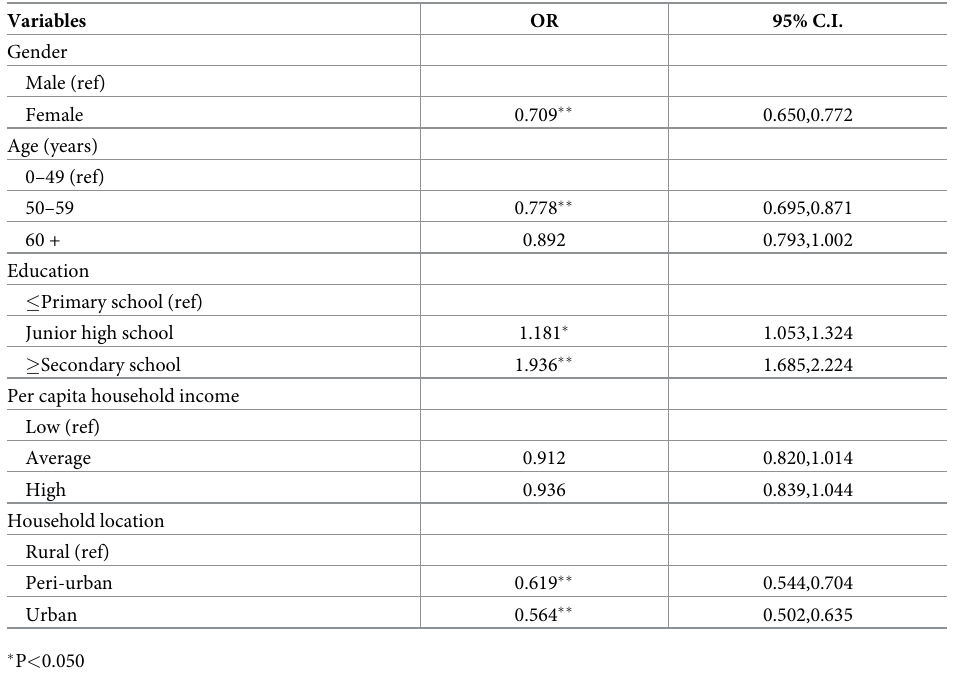
Table 3. Logistic regression estimates of residents’ disaster response knowledge #